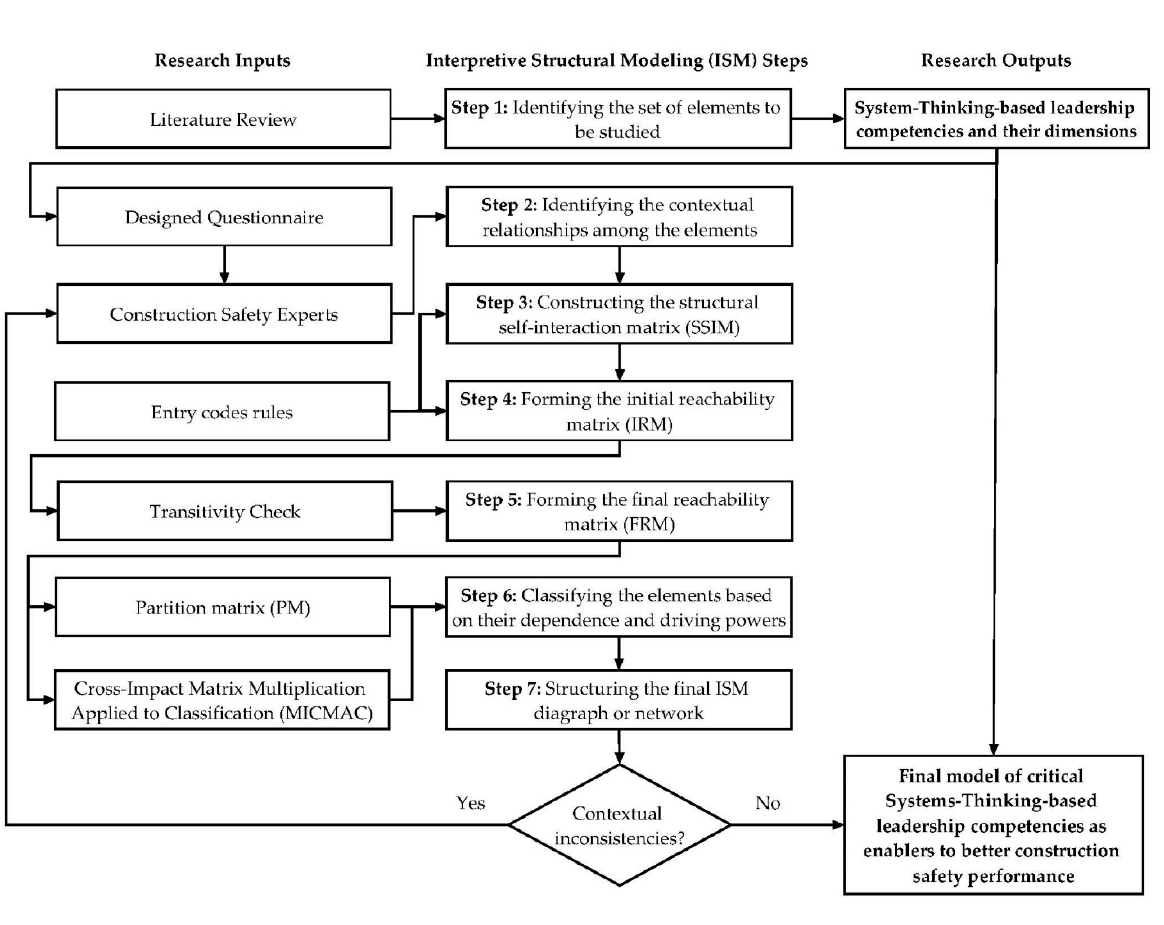
Figure 1. Research methodology flowchart and seven steps of the Interpretive Structural Modeling (ISM) technique. Table 2. Rules of constructing the Structural Self-Interaction Matrix (SSIM) and the Initial Reachability Matrix (IRM). Direction Scenario